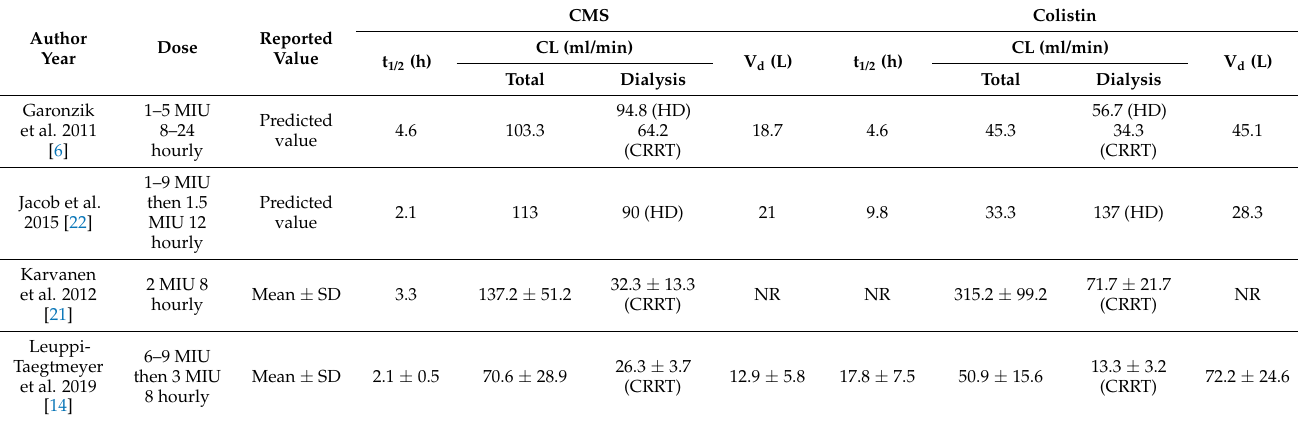
Table 5. Comparison of CMS and colistin pharmacokinetics parameters in plasma in patients receiving renal replacement